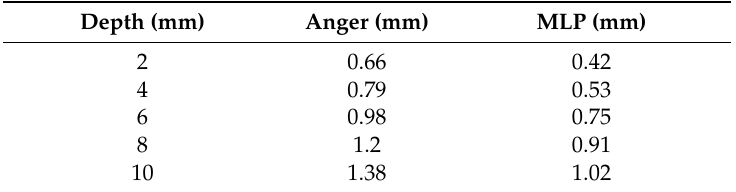
Table 2. Depth of interaction resolution for one detector module based on Anger logic and multilayer perceptron (MLP) positioning algorithms. The depth of interaction (DOI) estimation based on Anger logic was calculated virtually by considering two perpendicular virtual silicon photomultipliers (SiPMs) at the two side faces of the monolithic crystal.